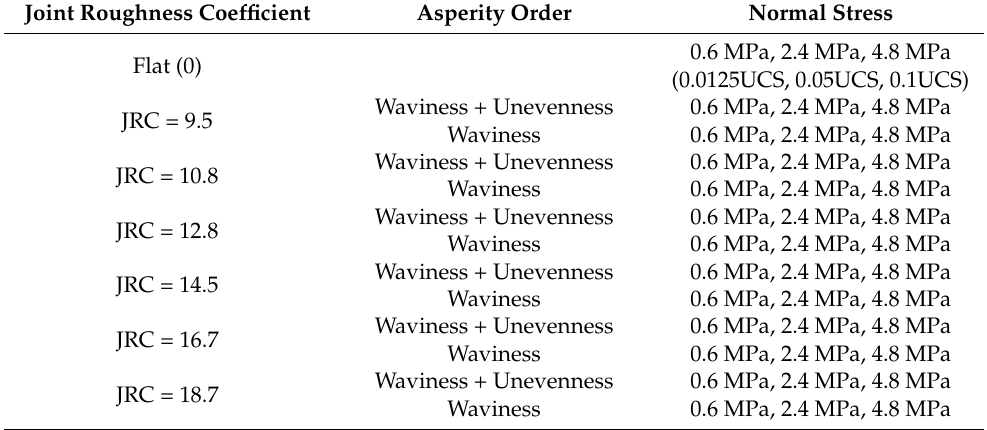
Table 4. Shear test